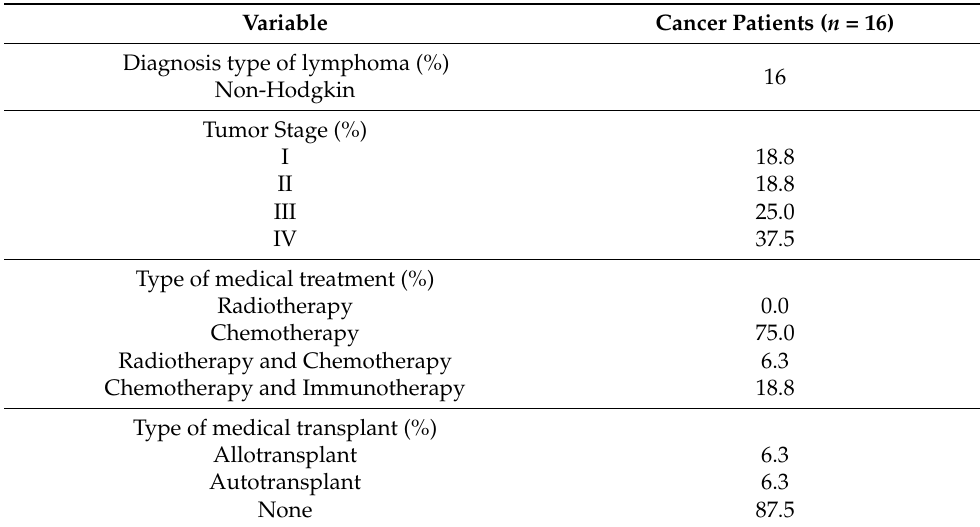
Table 2. Clinical characteristics of participating non-Hodgkin lymphoma cancer